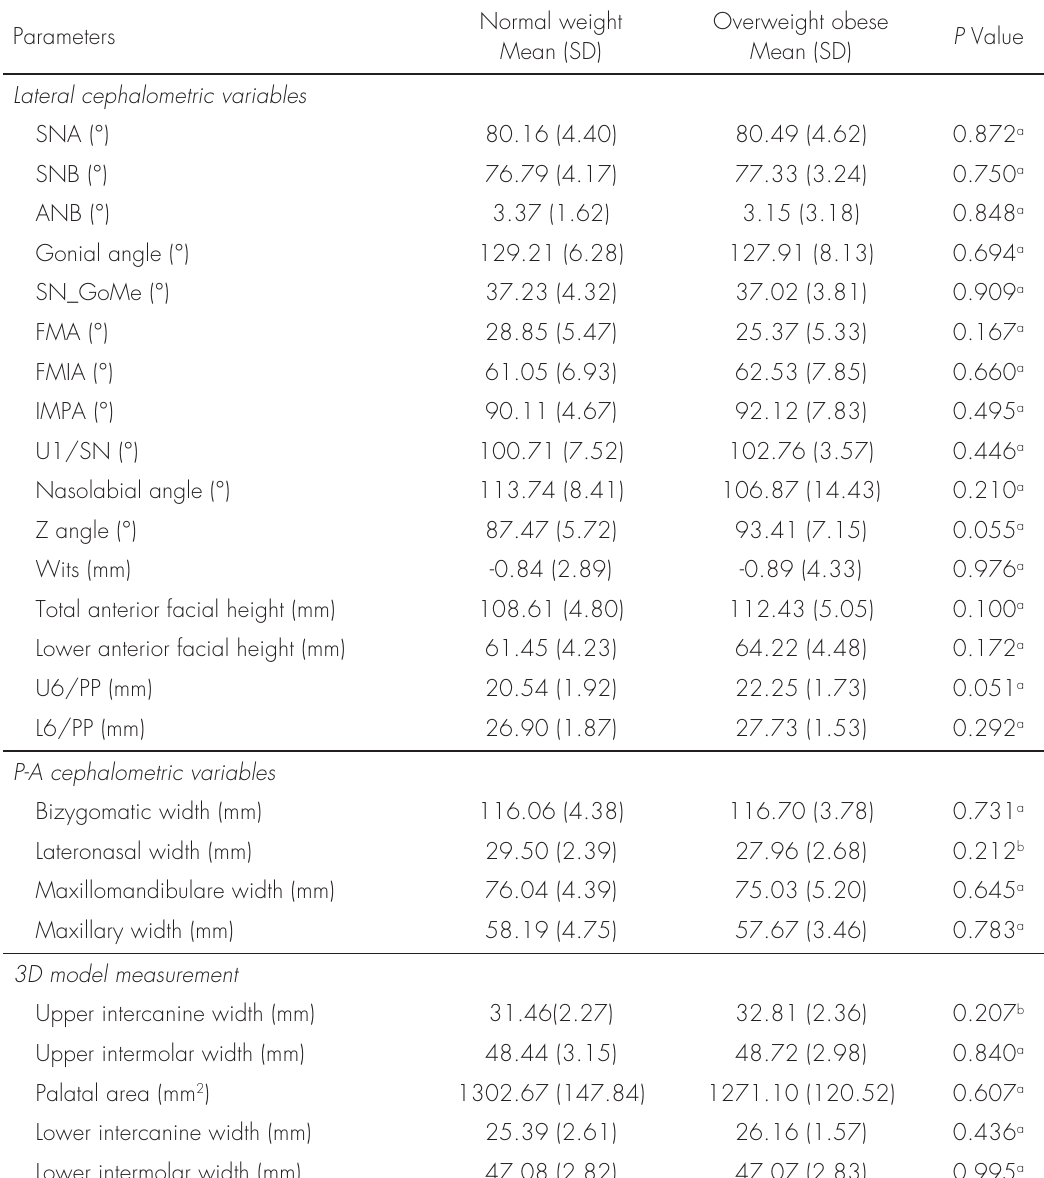
Table I. Comparison of initial (T0) lateral cephalometric between